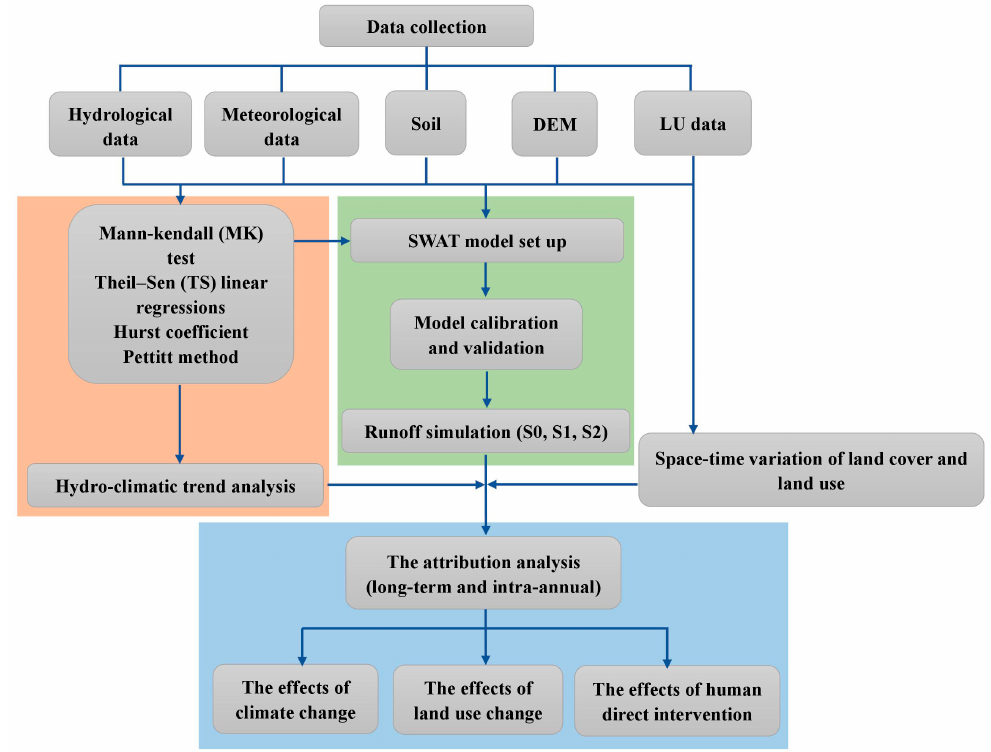
Figure 3. Overview of this study.